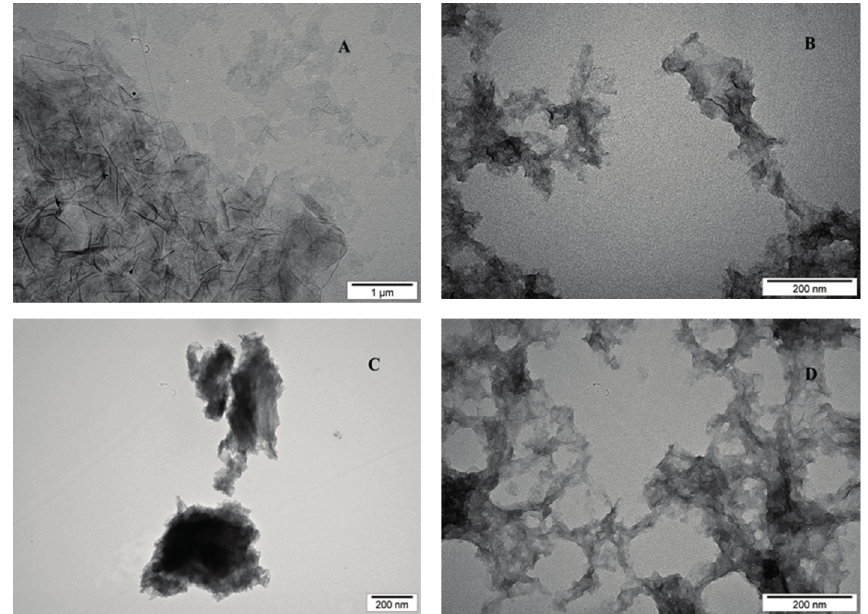
Figure 1. TEM image of graphene oxide ( A ); reduced graphene oxide ( B ); and reduced graphene oxide functionalised with arginine ( C ) and proline ( D ). The ζ potentials were for rGO: 19.5, rGO + Arg: 32.5, rGO + Pro: 39.8, Arg: 9.67 and Pro: 23.8